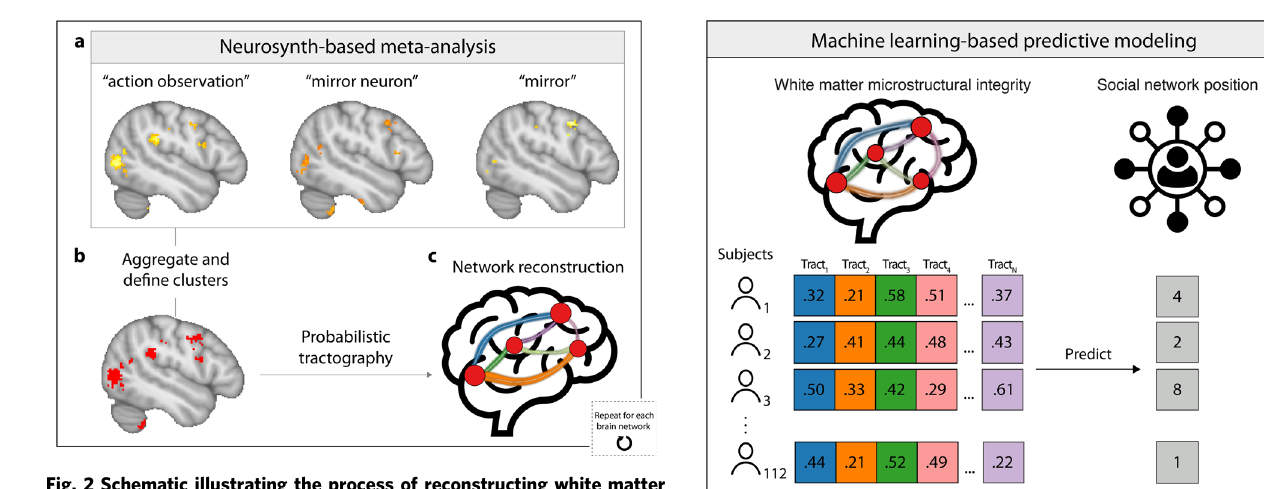
Fig. 2 Schematic illustrating the process of reconstructing white matter tracts between regions involved in particular facets of socio-affective processing. a Meta-analysis-based images of brain regions associated with a particular facet of socio-affective processing (e.g., mirroring) were generated by submitting sets of keywords (e.g., action observation, mirror neuron, mirror) to Neurosynth 22 . b These images were aggregated across terms in a set, and discrete regions of interest were identi fi ed. c For each subject, probabilistic tractography was then conducted to trace white matter tracts (colored lines in this schematic image) connecting each pair of brain regions (red nodes). This procedure was repeated to construct the affective processing, mentalizing, and face perception networks (see Methods for further details).